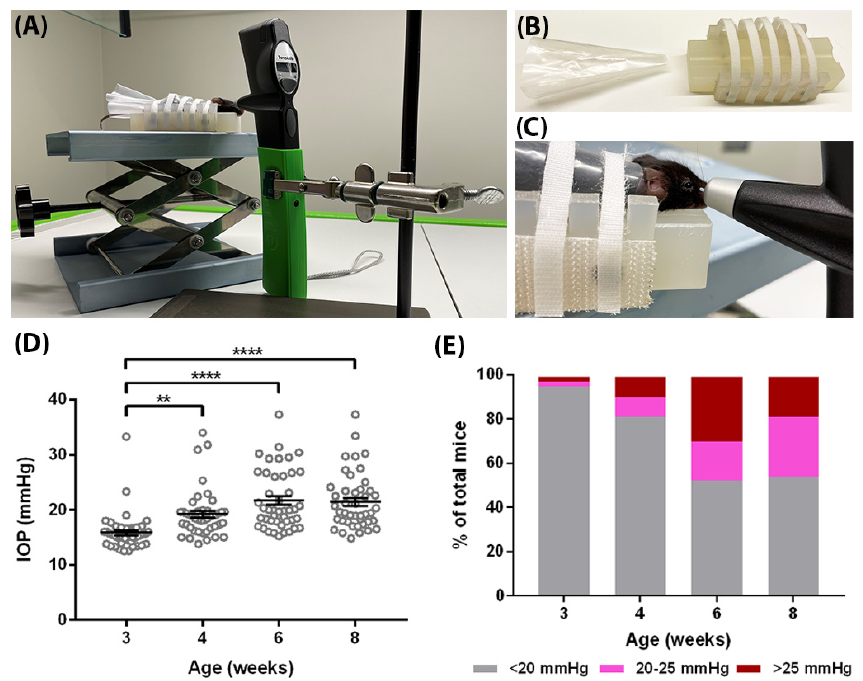
Figure 2. IOP elevation in egl1 mice. ( A ) Conscious IOP measurement setup. ( B ) Plastic cone and mouse restrainer for IOP measurement. ( C ) Close view of conscious IOP measurement. ( D ) The IOP was monitored in egl1 mice longitudinally. Significant IOP elevation was detected at 4 weeks of age and remained at all ages examined. Data are presented as means ± SEM ( n = 44). **: p < 0.01, ****: p < 0.001. ( E ) The IOP values from each time point were plotted by three ranges, <20 mmHg, 20–25 mmHg, and >25 mmHg. The IOP values demonstrated a wide range in mice of the same age.